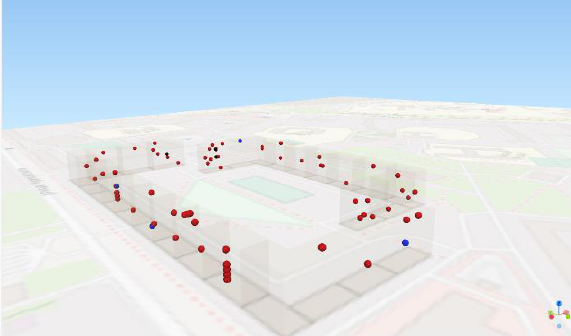
Figure 6 . The location of the hotbeds of infection in the buildings along Chudnovsky Street №8/1 and №8/2.